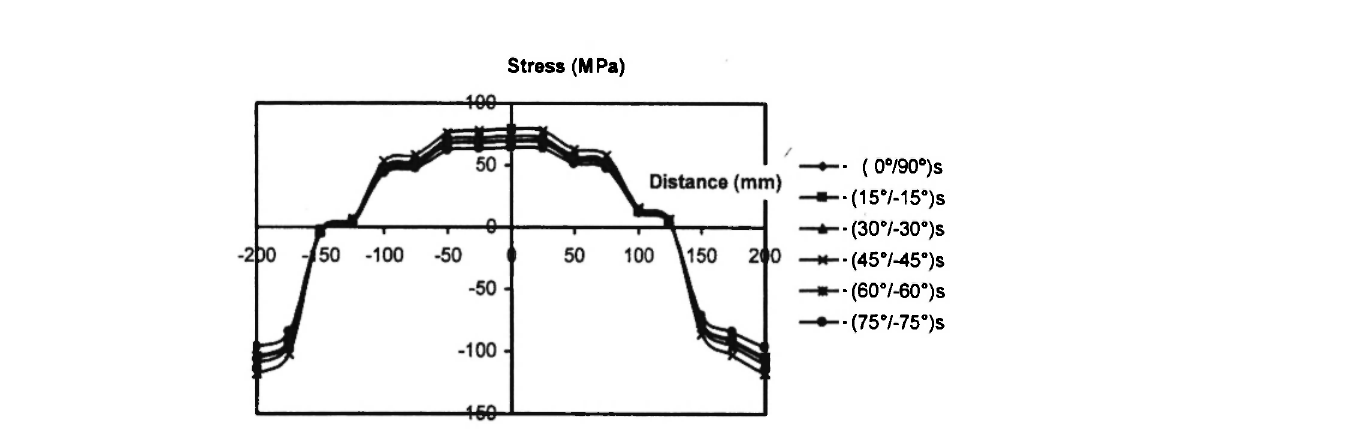
Fig. 3: Variation of the elastic-plastic stress component σ χ at the upper surface for symmetric cross-ply and angle-ply laminated plates.